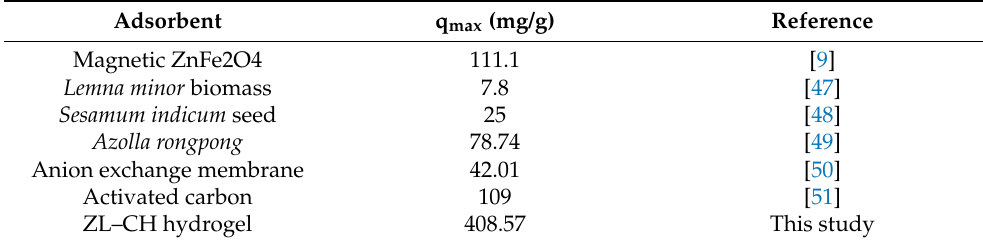
Table 7. Comparison of ZL–CH hydrogel with other